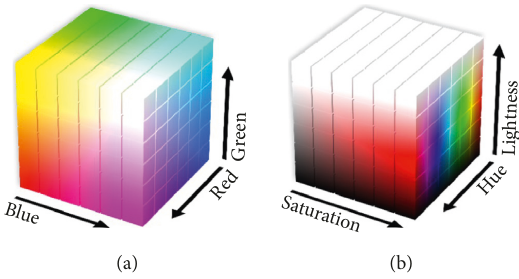
Figure 2: Cubic interpretation of RGB (a) and HSL (b)